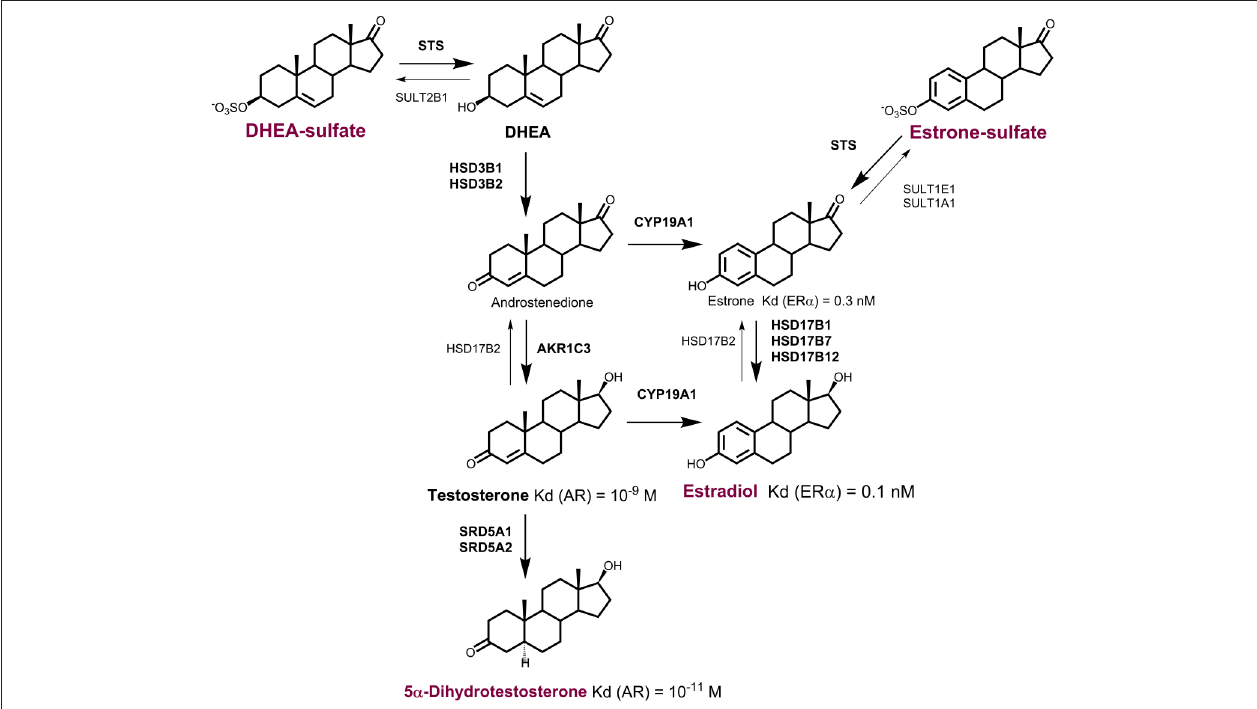
FIGURE 1 | Formation of active steroid hormones from DHEA-S and E1-S. In peripheral tissues, dehydroepiandrosterone sulfate (DHEA-S), and estrone-sulfate (E1-S) serve as precursors for formation of active steroid hormones. DHEA-S can be activated to estradiol (E2) via androstenedione by the actions of sulfatase (STS), 3 β -hydroxysteroid dehydrogenases type 1 and 2 (HSD3B1, HSD3B2), aromatase (CYP19A1), and the reductive 17 β -hydroxysteroid dehydrogenases (HSD17B1, HSD17B7, 17HSD12) or aldo-keto reductase (AKR1C3). E2 can also be formed from estrone sulfate (E1-S) by the action of sulfatase (STS) and reductive HSD17B. DHEA-S can be activated to active androgens. The most potent androgen 5 α -dihydrotestosterone can be formed from DHEA-S by the actions of STS and HSD3B1, or HSD3B2 and AKR1C3, and 5 α -reductases types 1 and 2 (SRD5A1, SRD5A2).